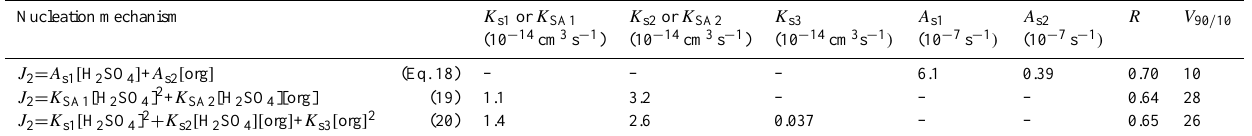
Table 3. Values of the optimized separate nucleation coefficients, with the corresponding correlation coefficients R and variations V 90 / 10 . Nucleation mechanism